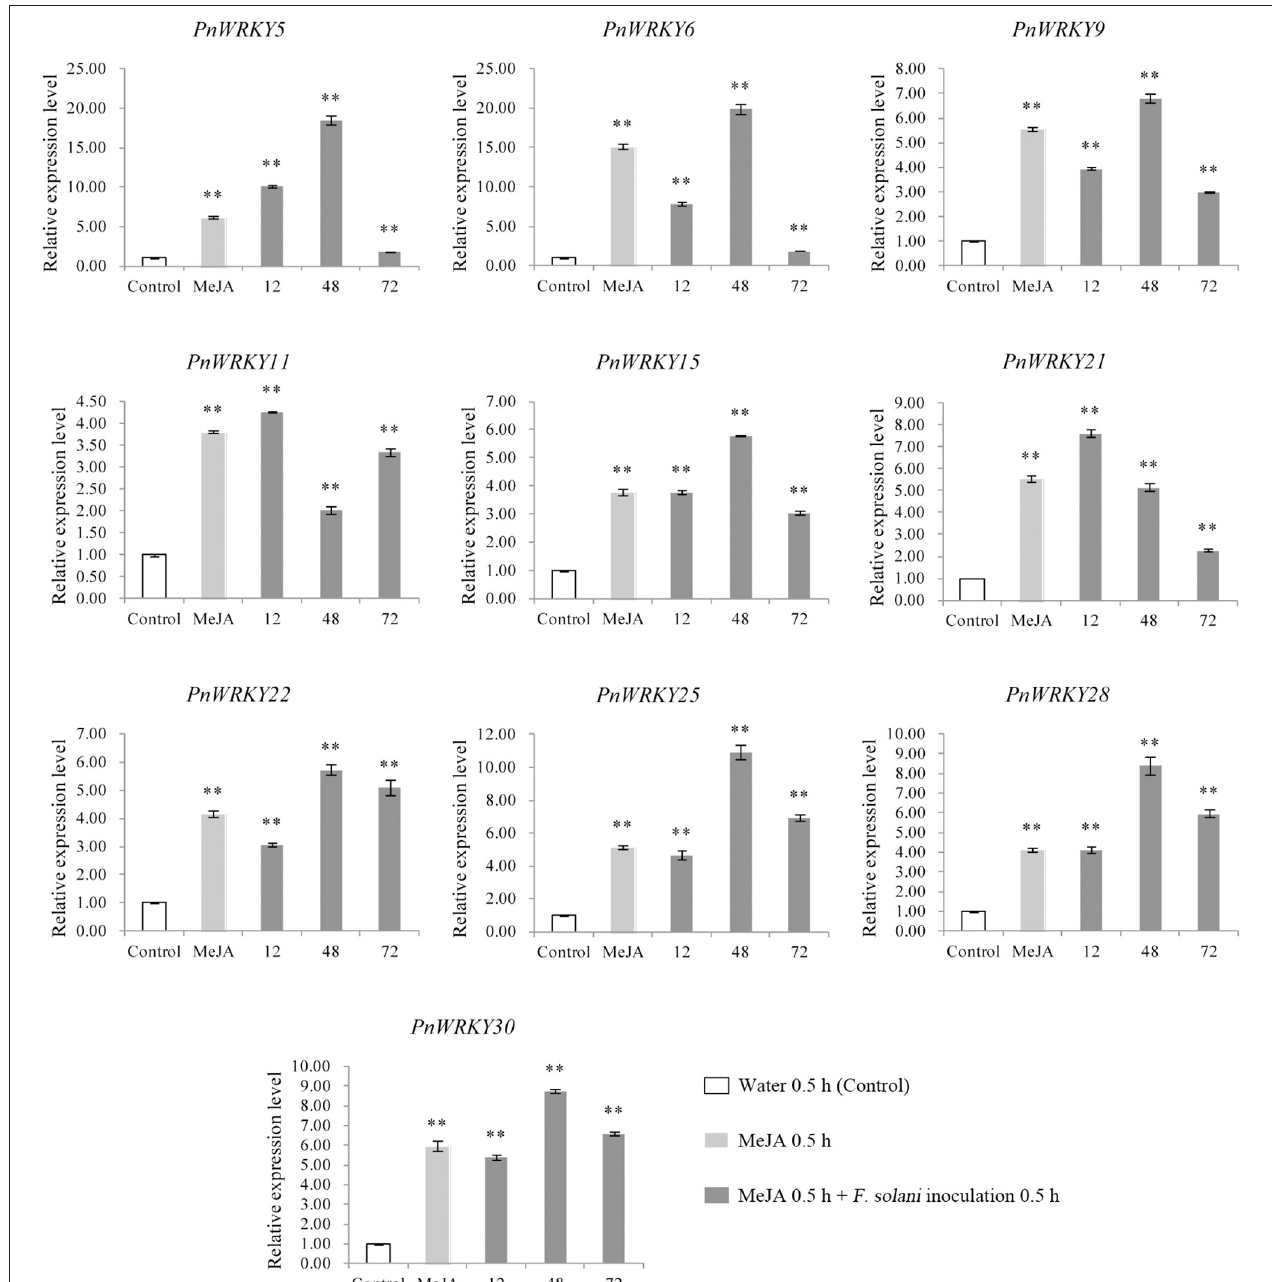
FIGURE 3 | The expression levels of PnWRKYs were estimated in P. notoginseng roots pretreated with MeJA followed by F. solani infection . Panax notoginseng roots were pre-treated with MeJA, and after treatment for 24h, the treated-roots were further inoculated with F. solani . The MeJA-treated roots were collected after treatment for 24h, and the inoculated roots were collected at 12, 48, and 72h post F. solani inoculation. P. notoginseng roots treated with sterile water for 30min were used as control. The 2 − 11 Ct method and t test (** p < 0.01) were used to calculate the relative gene expression levels and statistical difference.